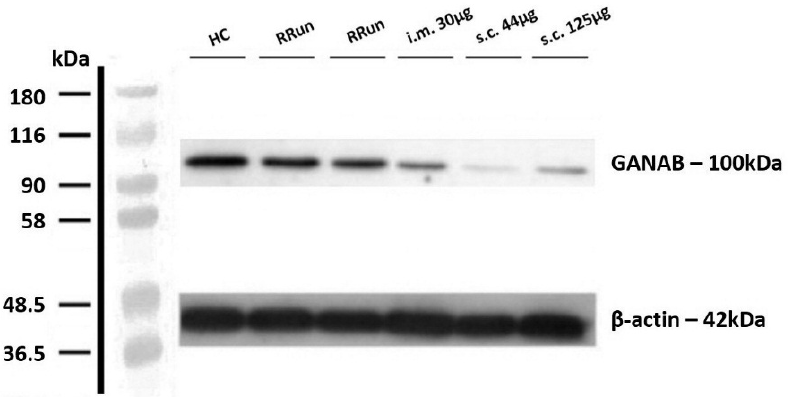
Figure 1. Example image that representing the western blotting of GANAB. Value of GANAB increasing from the IFNbeta-1a-treated MS patients (intramuscular injection (i.m.) 30 μ g, subcutaneous injection (s.c.) 125 μ g, s.c. 44 μ g) to relapsing remitting untreated patients (RRun) compared to HCs. Note the gradually decreasing densitometry from the intramuscular to the subcutaneous formulation. All densitometric measurements of GANAB were normalized with beta-actin. HC, healthy control; RRun, relapsing remitting untreated patient; i.m. 30 μ g, patient treated with a 30 μ g intramuscular weekly formulation of IFNbeta-1a; s.c. 44 μ g, patient treated with the subcutaneous high-dose three-times weekly formulation of IFNbeta-1a; s.c. 125 μ g, patient treated with the subcutaneous pegylated formulation of IFNbeta-1a every two weeks.